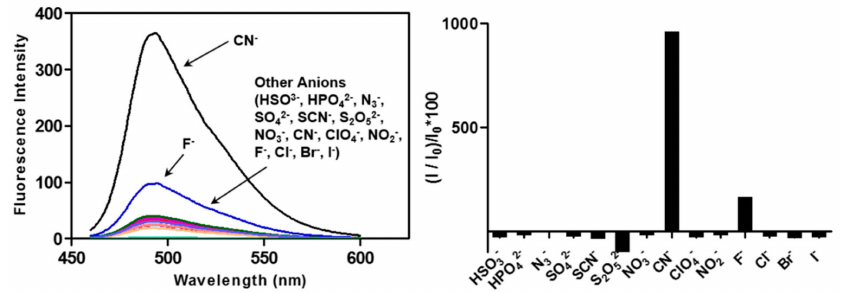
Figure 6. Selectivity of CP3 -Cu 2+ for cyanide among various anions examined in DMSO solution. Changes in emission spectra of CP3 -Cu 2+ (1 µ M) in DMSO upon addition of 20 equiv. of various anions (CN ´ , HSO 3 ´ , HPO 42 ´ , N 3 ´ , SO 42 ´ , SCN ´ , S 2 O 52 ´ , NO 3 ´ , ClO 4 ´ , NO 2 ´ , F ´ , Cl ´ , Br ´ , I ´ ) ( λ ex = 441